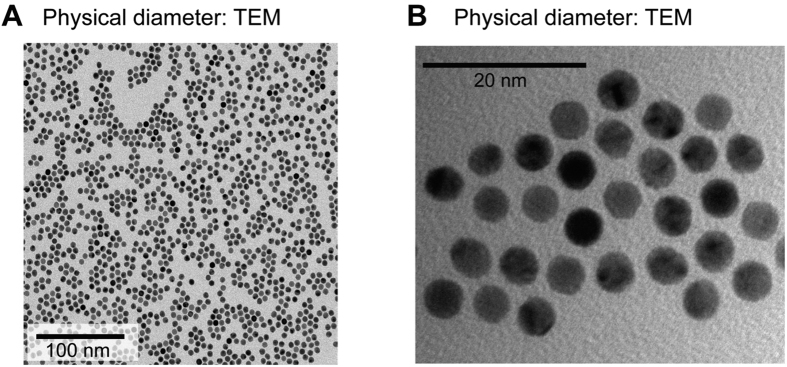
Gold nanoparticle synthesis and characterization.(A) A TEM image showing spherical morphology and physical diameter of AuNPs. Note that the AuNPs sizes are fairly uniform (B) A magnified view clearly revealing the conserved AuNPs size distribution.